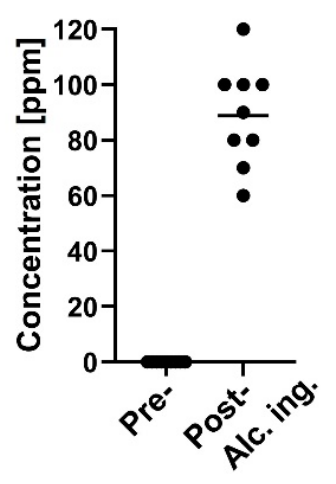
Figure 8. Breath ethanol concentration of pre- ( n = 9) and post- ( n = 9) alcohol ingestion. The mean value is represented as a horizontal line. Pre-alcohol ingestion samples exhibited undetectable levels (i.e., < 20 ppm).